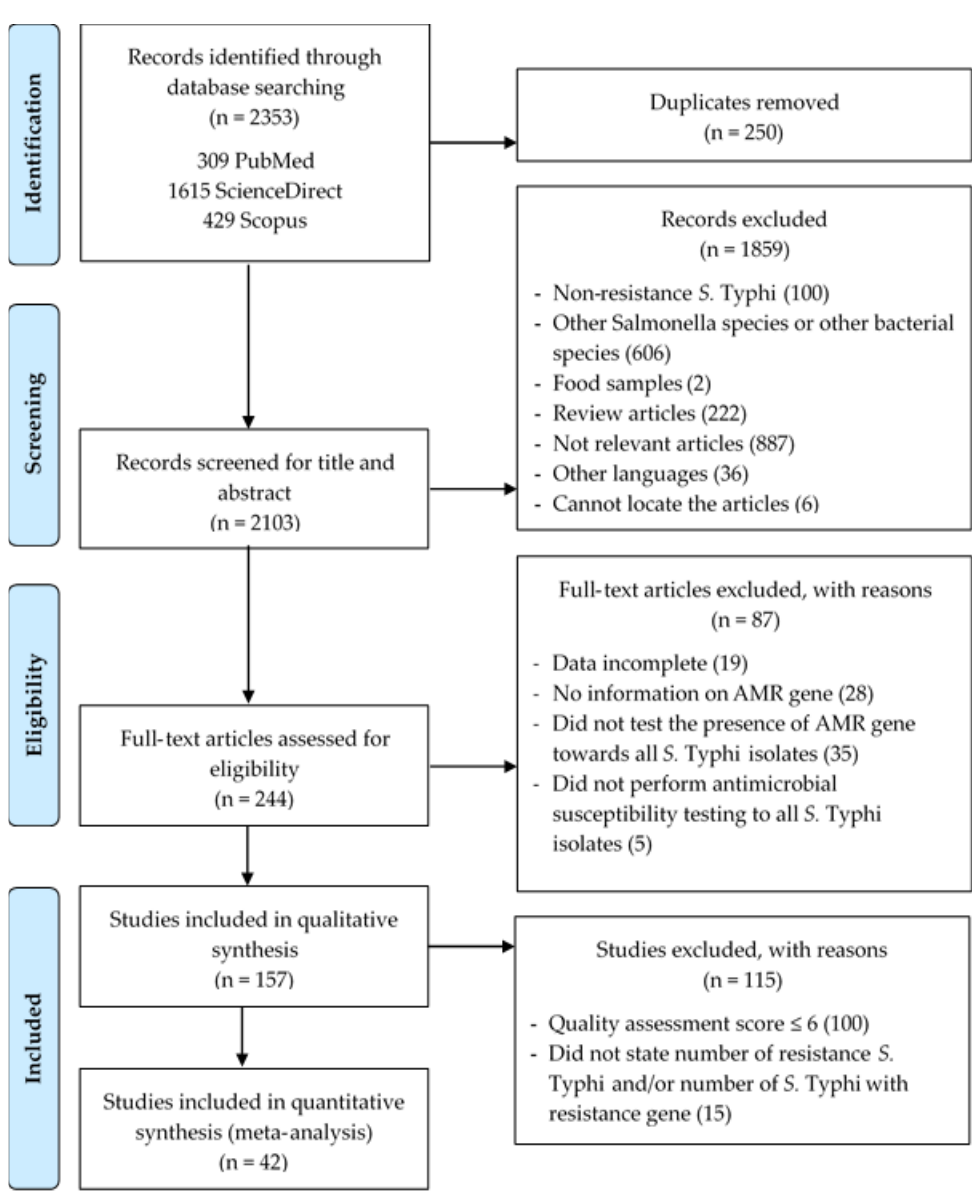
Figure 1. PRISMA flowchart illustrating the process of identifying, screening and selecting eligible articles used in this study.